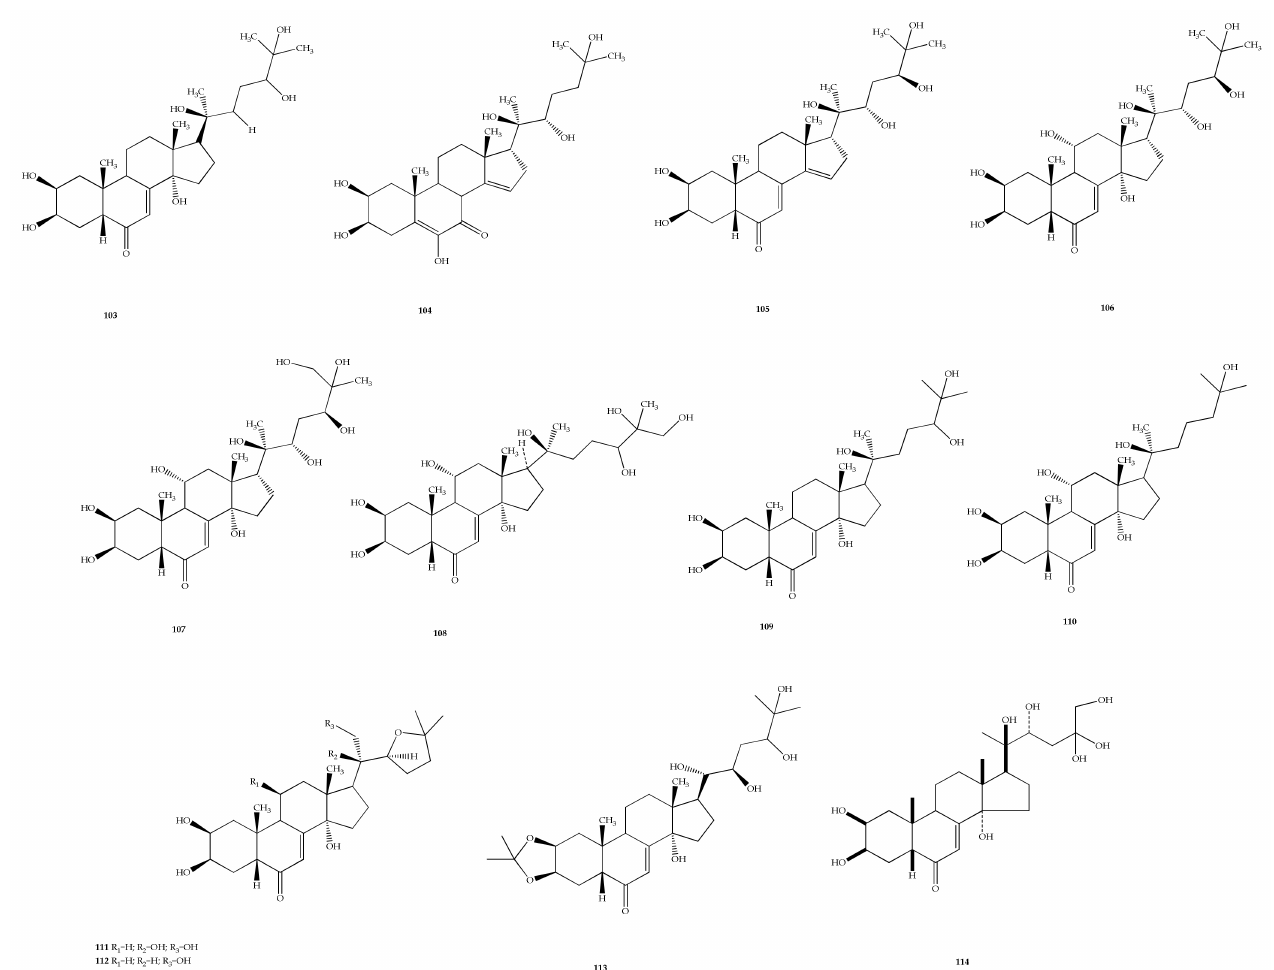
Figure 5. Chemical structures of ecdysteroids 103 – 114 found in Vitex